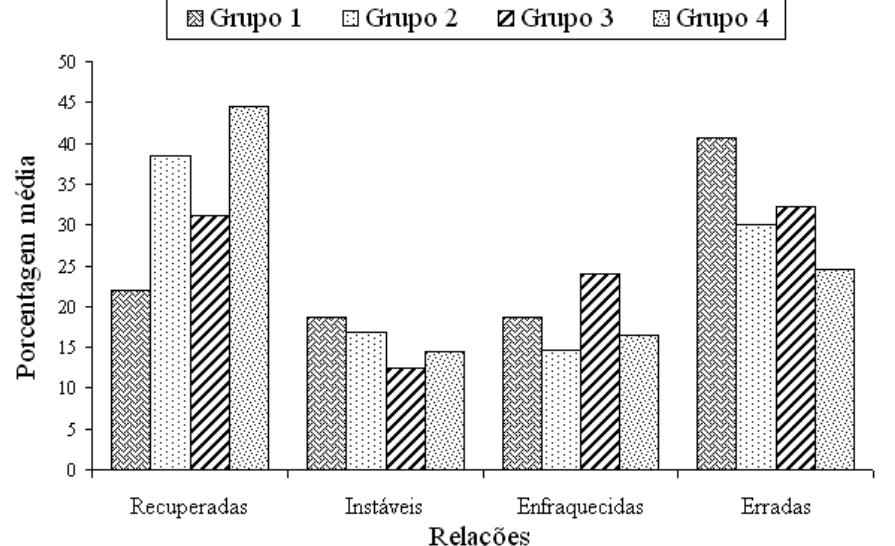
Figura 3. Porcentagem média de relações recuperadas, instáveis, enfraquecidas e erradas no Teste de Manutenção em relação ao número total de relações